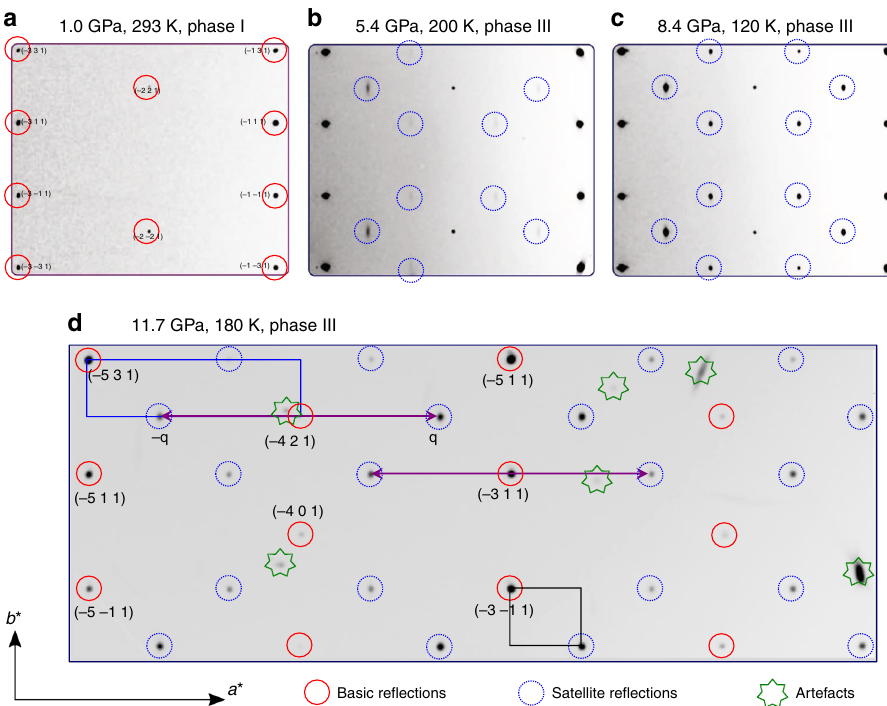
Fig. 3 Examples of reciprocal lattice planes ( hkl ) of Fe 4 O 5 . These plots correspond to different pressure and temperature conditions (indicated for each plot). a Basic re fl ections corresponding to the original Fe 4 O 5 -I structure, highlighted by red circles. b , c Emergence of superlattice re fl ections, highlighted by blue circles (in b these re fl ections are rather weak and blurred, but in c they are strong and clear). d Reconstruction of ( hkl ) reciprocal lattice planes, which reveals two possible unit cells of Fe 4 O 5 -III. The fi rst option is an orthorhombic C -centered “ average ” cell, shown in the upper left corner together with its modulation wave vector q (Fe 4 O 5 -III-b). The second option is a C -centered unit cell with a tripled lattice parameter a , compared to the average cell (Fe 4 O 5 -III-a), highlighted at the bottom of the plot